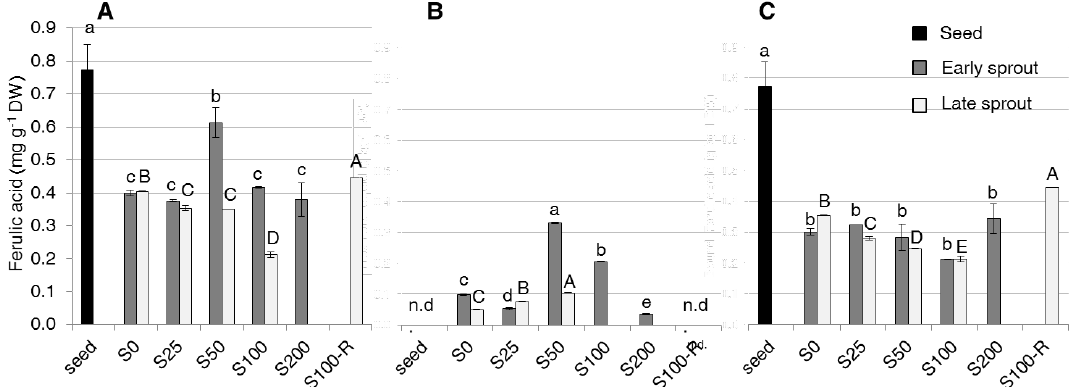
Figure 5. Total ( A ), free ( B ) and bound ( C ) ferulic acid (FA) content (mg g −1 DW) in seeds, early and late sprouts of rapeseed sprouted and grown with salt (NaCl) concentration 0, 25, 50, 100, 200 mM (S0, S25, S50, S100, S200, respectively) or sprouted with 100 mM and then grown with distilled water as recovery treatment (S100-R). Average values of duplicate determinations ± standard error are depicted. n.d., not detectable. Different letters within each graph indicate statistically significant differences at p = 0.05 (Fisher’s LSD). Lower case letters are for comparison within early sprouts; upper case letters for comparison within late sprouts.